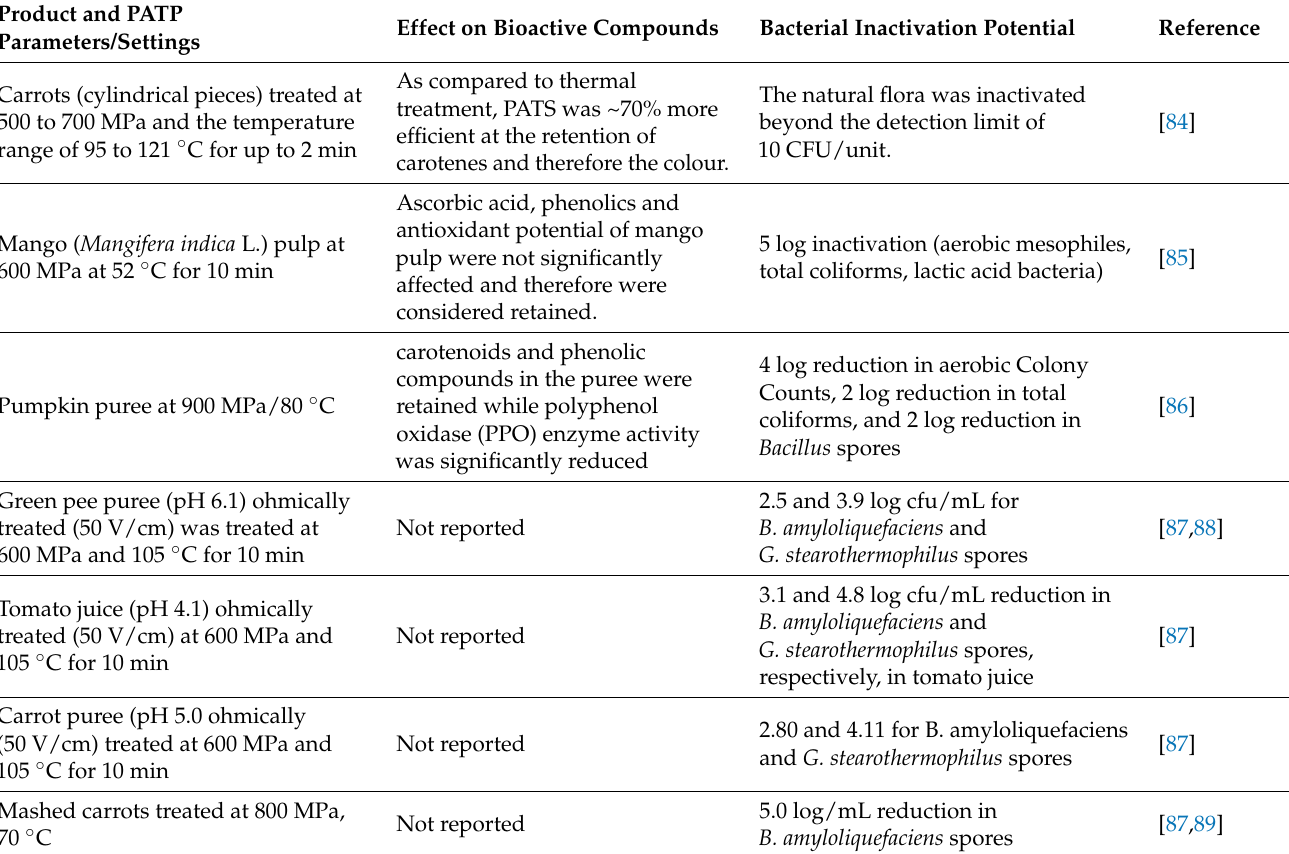
Table 5. Effect of PATP with heat on bacterial inactivation in fruit/vegetable